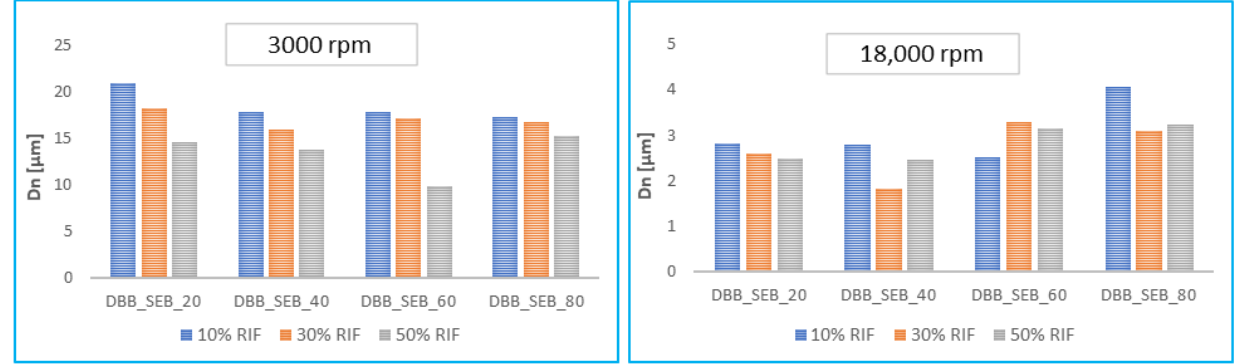
Figure 8. Comparison of the sizes of the RIF-loaded large particles ( left ) and small particles ( right ). Coagulation behaviour of microspheres has been examined by measuring zeta poten- tial. Zeta potential (ZP) of small blank and RIF-loaded (initial amount of RIF %) micro- spheres are presented in Table 8. Table 8. Comparison of the zeta potential of small blank and RIF loaded (50%) microspheres.